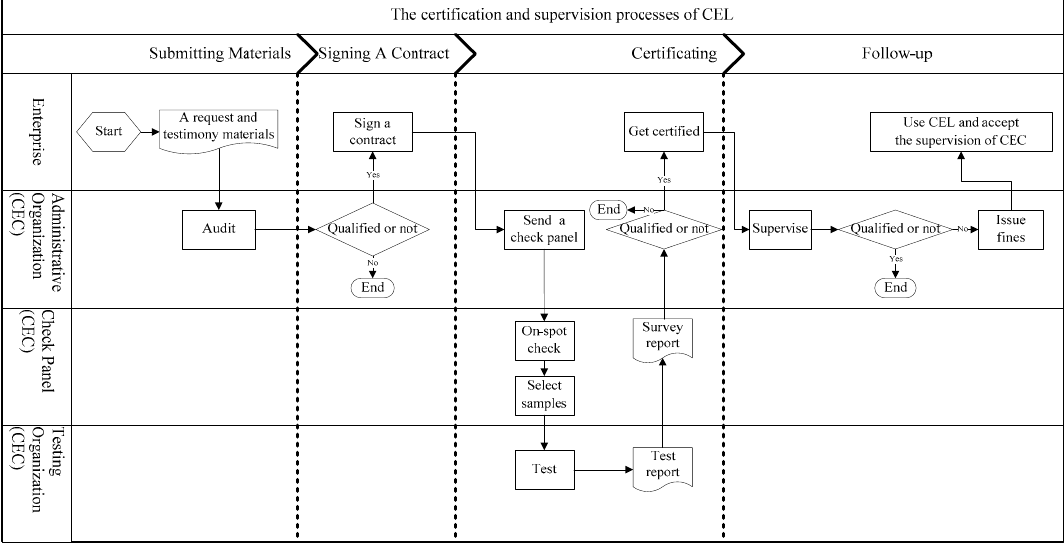
Figure 1. The certification and supervision processes of CEL (Chinese Environmental Labeling).